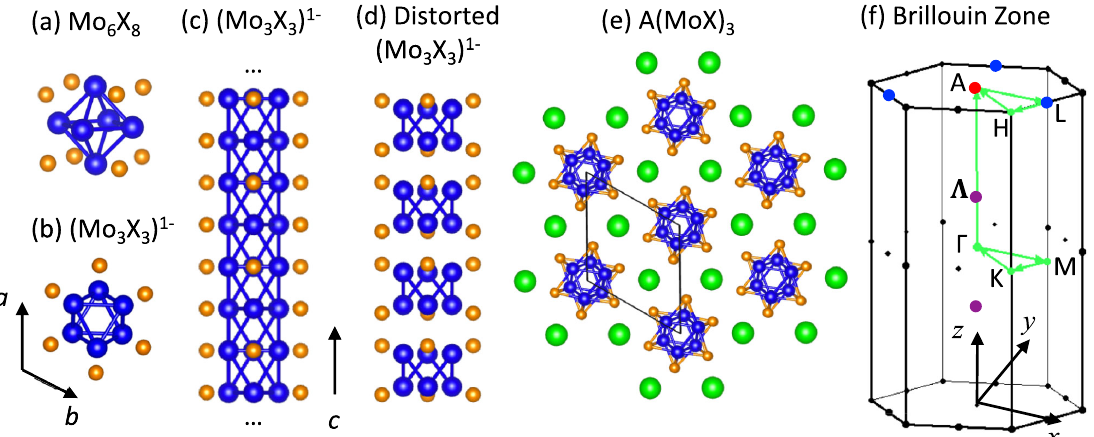
FIG. 1. (a) Structure of the (Mo 6 X 8 ) cluster unit with a Mo 6 octahedral surrounded by a cubic X 8 cage. (b) Top and (c) side view of the quasi-1D chain ð Mo 3 X 3 Þ 1 − . (d) Side view of the quasi-1D chain ð Mo 3 X 3 Þ 1 − with Peierls distortion. (e) Crystal structure of the cluster compound A ð MoX Þ 3 . The blue, orange, and green balls denote Mo, X, and A atoms, respectively. (f) Hexagonal Brillouin zone and the high-symmetry k path for band structure calculation. The dots mark the inequivalent Dirac points (one A point, three L points, and two Λ points representing Λ 1 and Λ 2 ) in undistorted